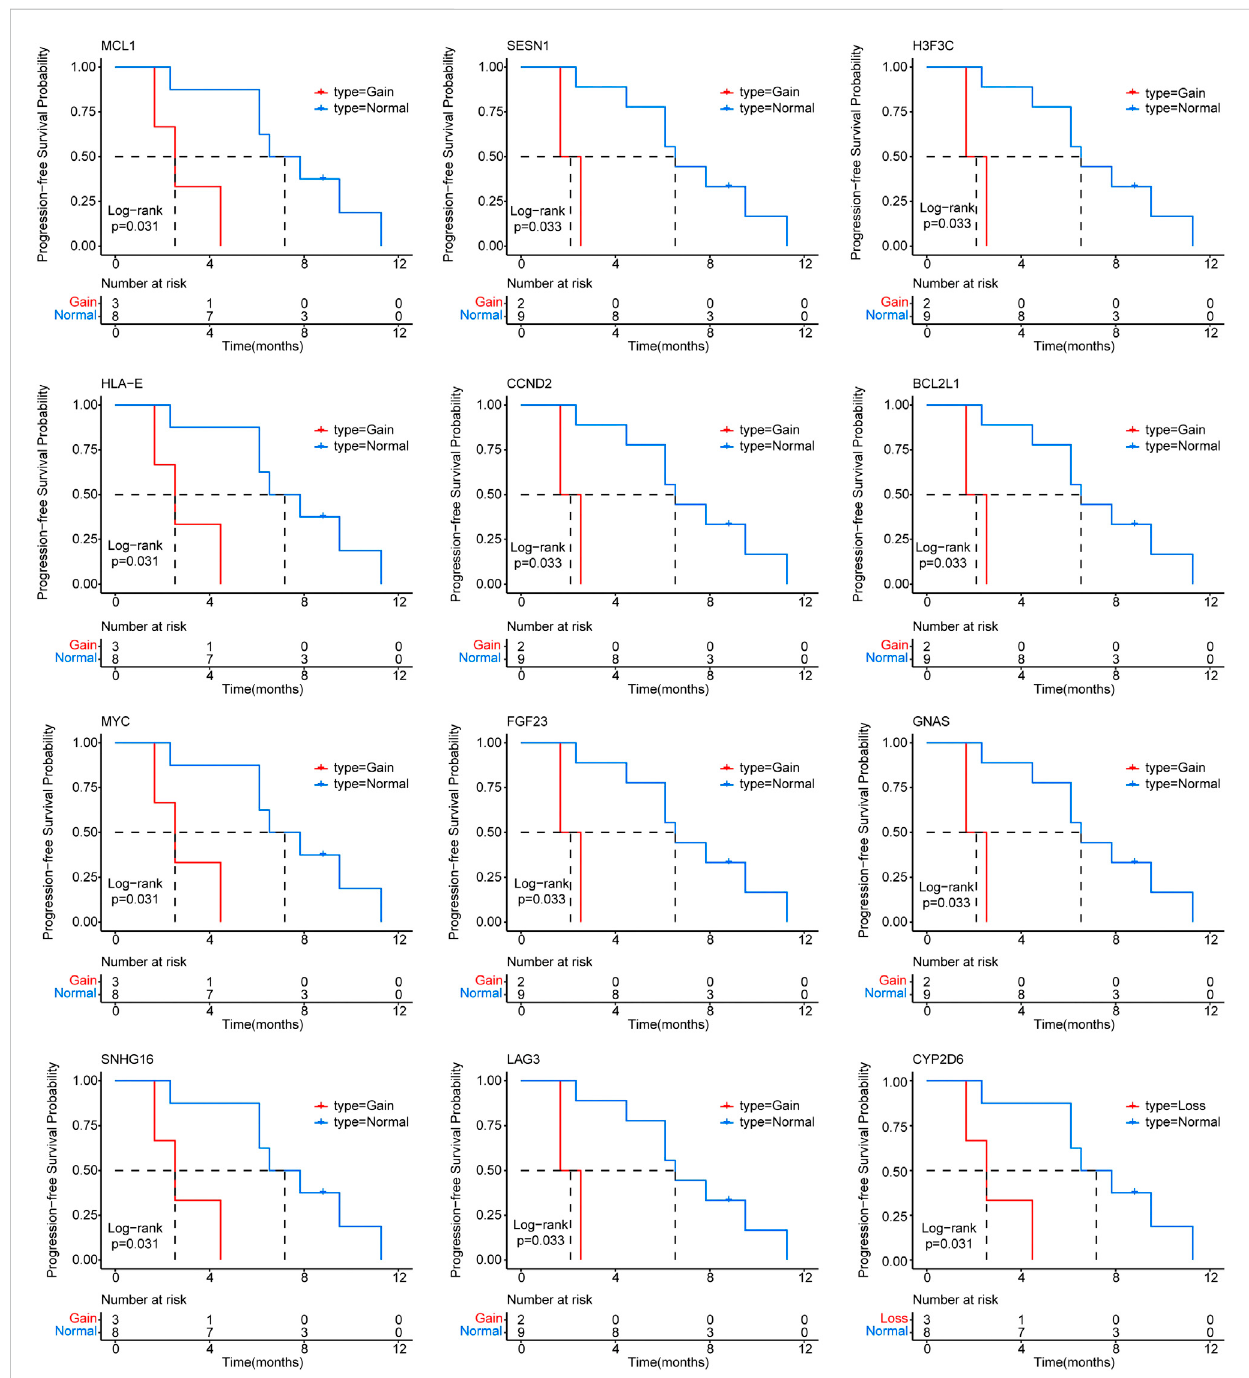
FIGURE 3 Correlation of circulating tumor DNA (ctDNA) gene mutations with progression-free survival (PFS) in advanced triple negative breast cancer (TNBC) patients receiving immune checkpoint inhibitor (ICI)